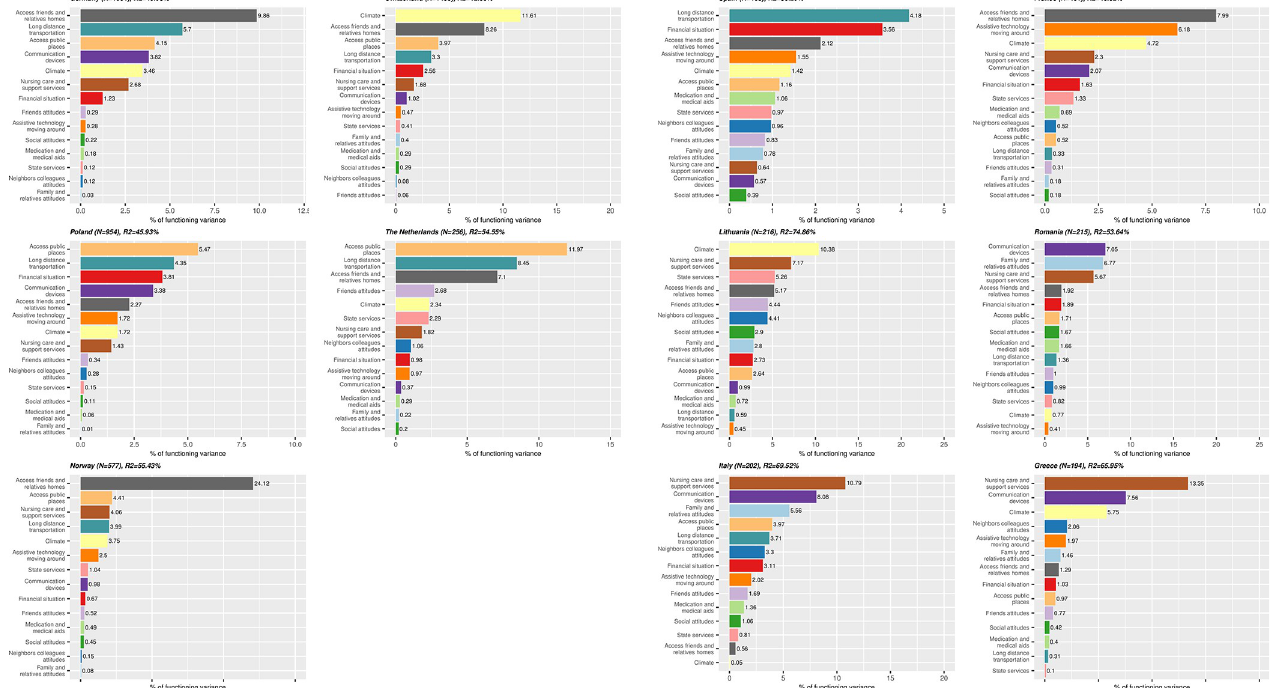
Fig 5. a. Relative importance of each environmental factors in explaining the total variation of functioning scores in countries with representative samples, when controlling for chronological age and type of injury. For each country, the full model variation when considering EFs and chronological age and type since injury as predictors is indicated in each country figure’s title. b. Relative importance of each environmental factors in explaining the total variation of functioning scores countries with convenience samples, when controlling for chronological age and type of injury. For each country, the full model variation when considering EFs and chronological age and type since injury as predictors is indicated in each country figure’s